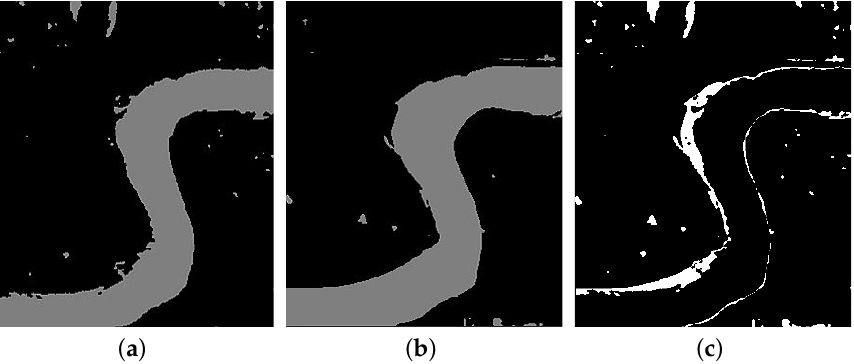
Figure 17. Classification and change detection maps for the Yellow River dataset by PCC. ( a ) Classification image for the SAR image. ( b ) Classification image for the optical image. ( c ) Resulting